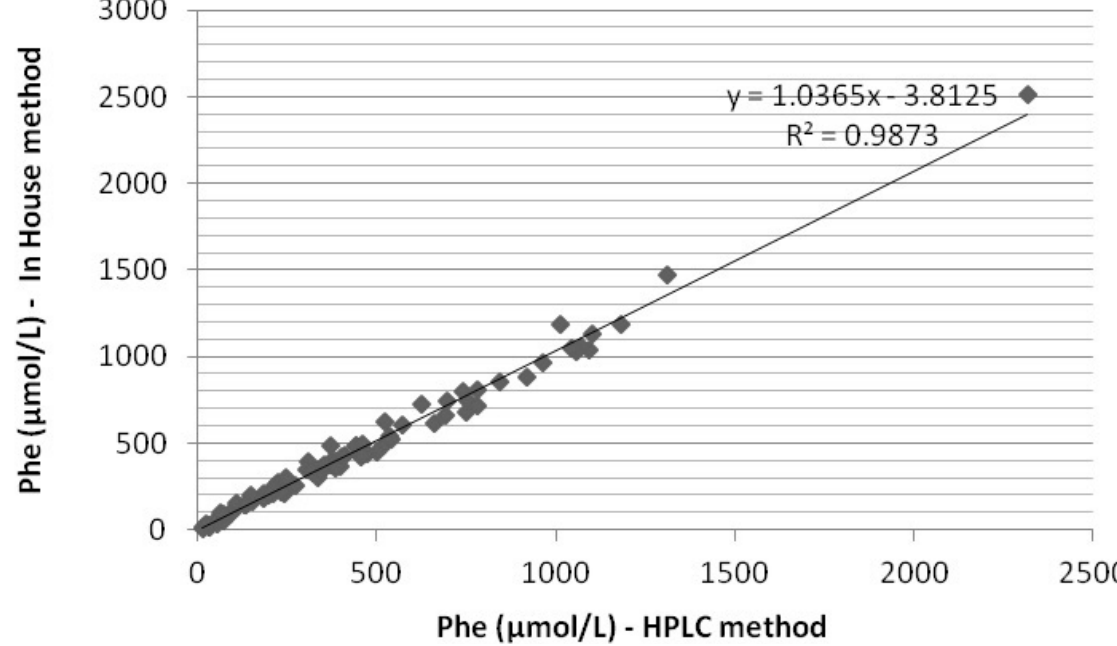
Figure 1. Correlation between phenylalanine (Phe) concentration in dried blood spots measured by the in-house method (method A) and by high-performance liquid chromatography (HPLC) (n = 89 blood